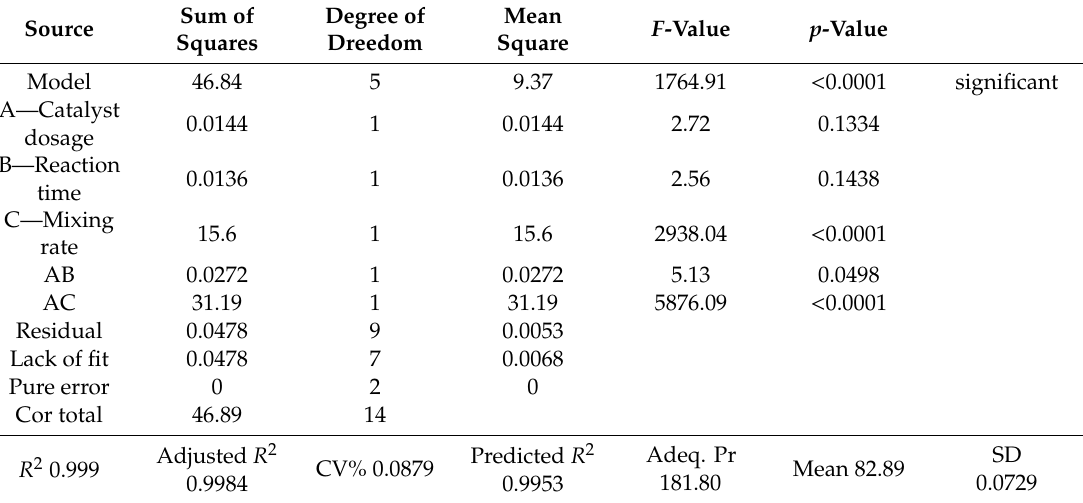
Table 6. ANOVA for SO 42 − removal by zeolite—reduced two-factor interaction (2FI) model.